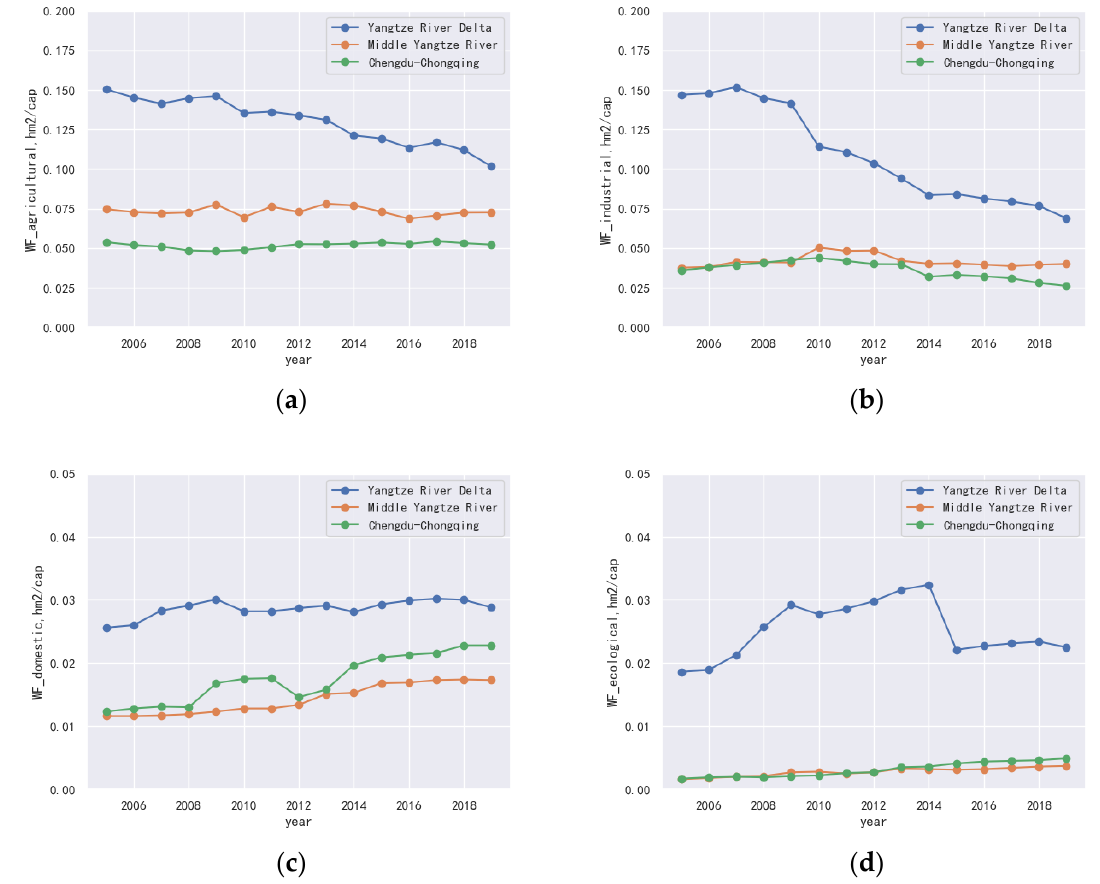
Figure 2. Trends of changes in WEFs by water use types for three major urban agglomerations: ( a ) agricultural WEF; ( b ) industrial WEF; ( c ) domestic WEF; and ( d ) eco-environment WEF.